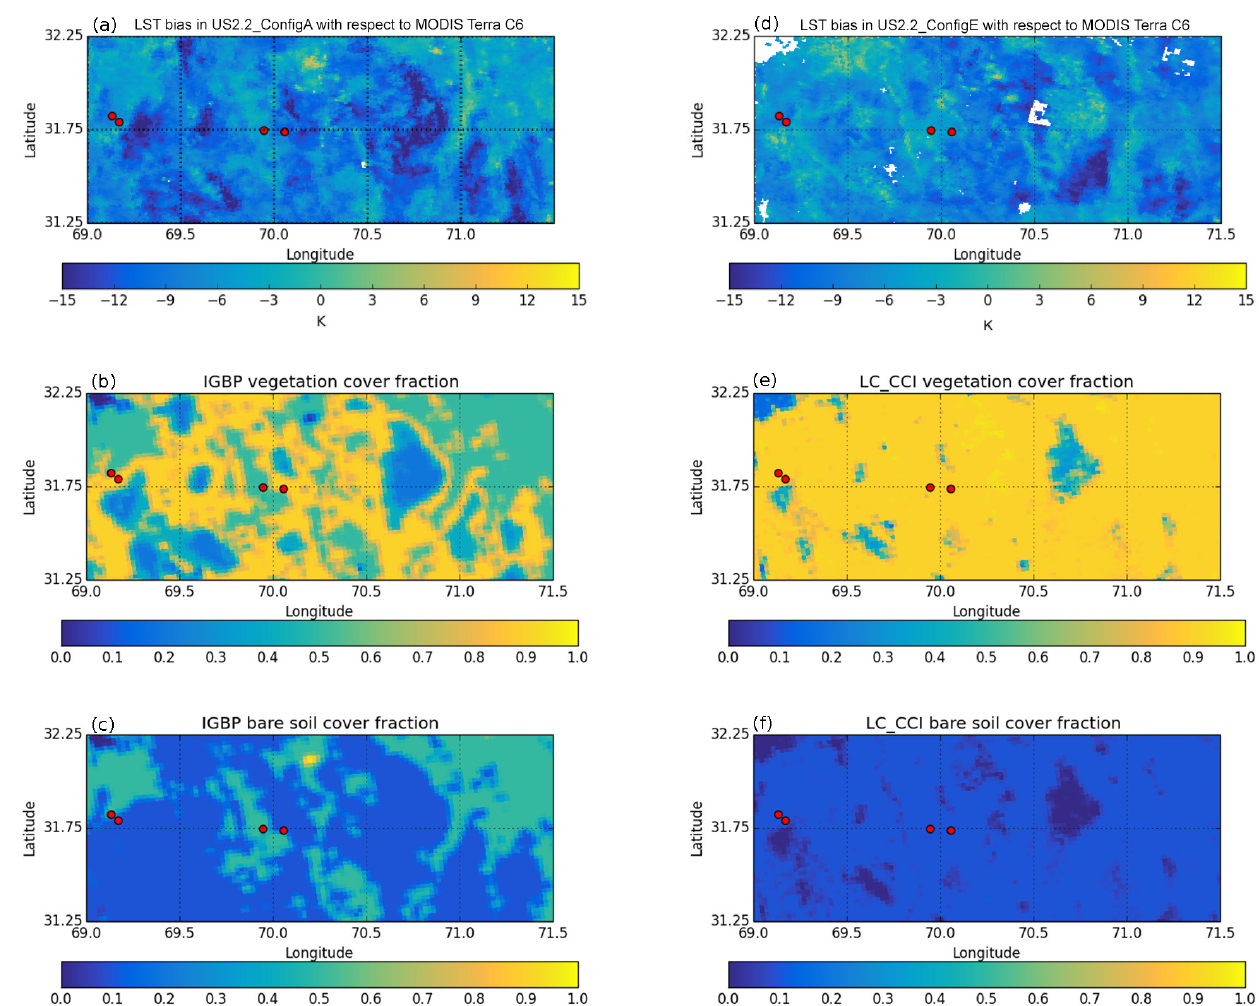
Figure 5. (a) Spatial distribution of surface temperature biases in the US2.2_ConfigA with respect to MODIS Terra Collection 6 on 13 May 2013. (b) The IGBP total grass (C3 and C4) and shrub cover fraction for the US2.2 configuration. (c) The IGBP bare soil cover frac- tion for the US2.2 configuration. (d) Spatial distribution of surface temperature biases in the US2.2_ConfigD with respect to MODIS Terra Collection 6 on 30 May 2018. (e) The LC_CCI total grass (C3 and C4) and shrub cover fraction for the US2.2 configuration. (f) Bare soil cover fraction for the US2.2 configuration. Red dots represent Lucky Hills (31.75 ◦ N, 110.05 ◦ W), Kendall Grassland (31.73 ◦ N, 109.94 ◦ W), Santa Rita Mesquite (31.82 ◦ N, 110.87 ◦ W) and Santa Rita Grassland (31.79 ◦ N, 110.83 ◦